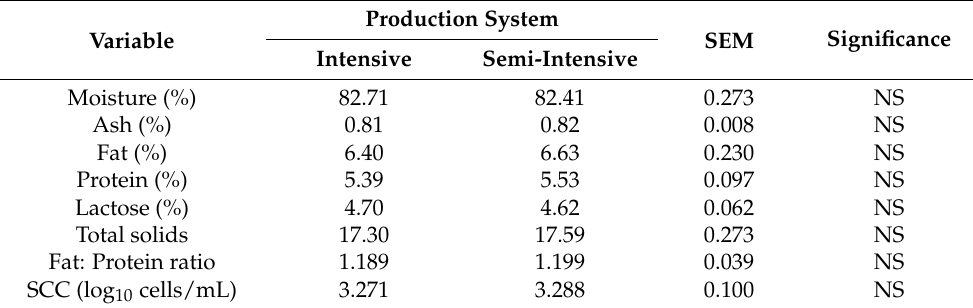
Table 1. Effect of the production system on sheep milk chemical composition, fat/protein ratio, and somatic cell